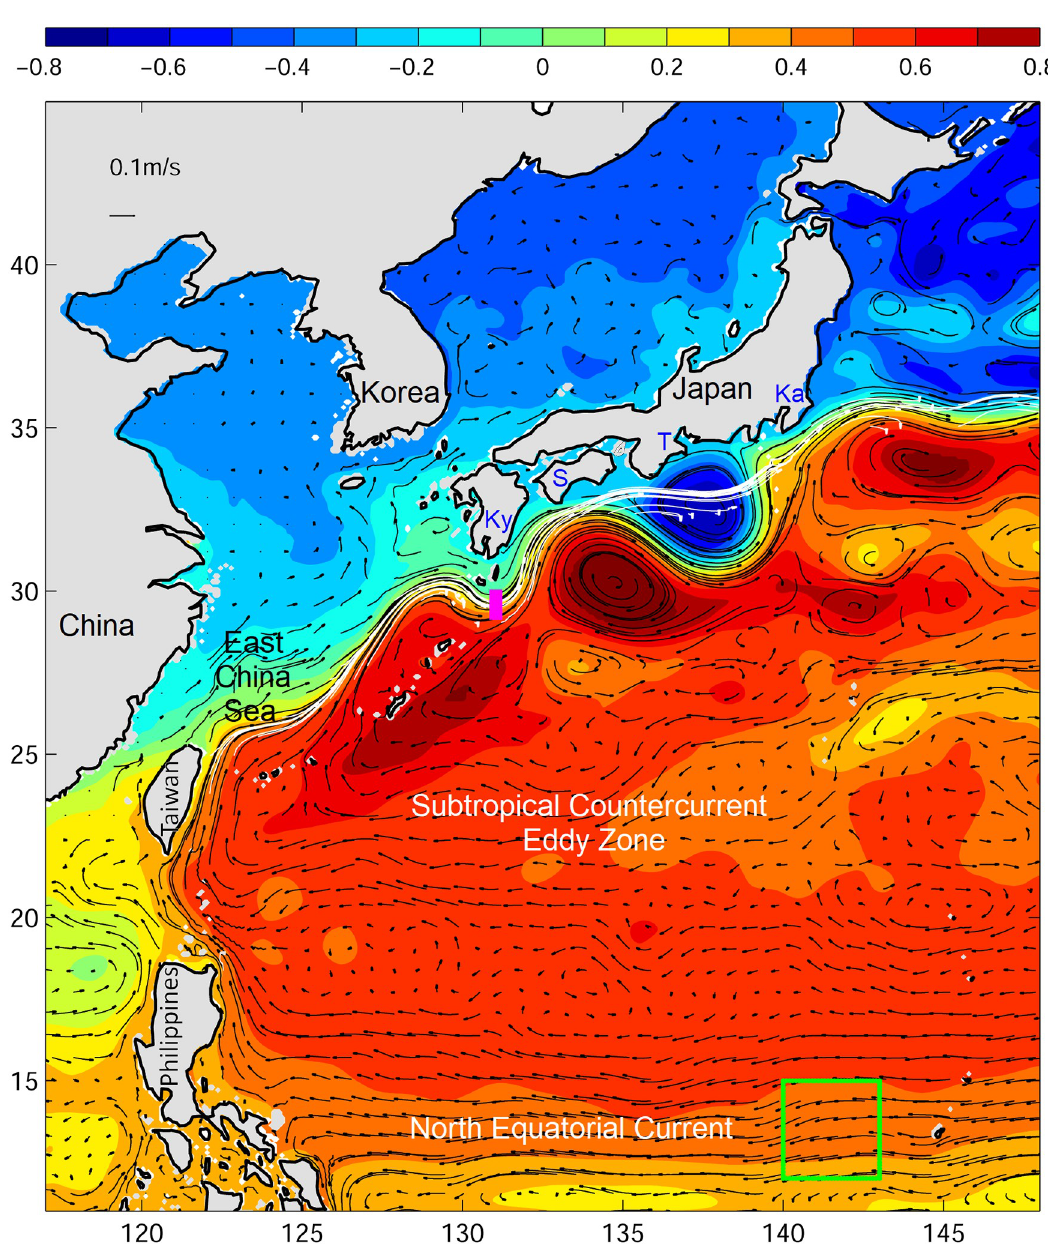
Fig 2. Mean ocean circulation during the 2018 eel catch season (November 2017 to May 2018). Color shading is sea surface height (m), and vectors are 50 − 250 m mean ocean currents. Ky, S, T, and Ka show the Kyushu, Shikoku, Tokai, and Kanto regions of Japan, respectively. The green box shows the spawning area where v-larvae were released. Magenta box south of Kyushu shows the release region for examining the effect of the Kuroshio large meander with different swimming behaviors. The white line shows where the ocean current was stronger than 0.4 m/s during the 2010 Kuroshio non-large meander eel catch season.